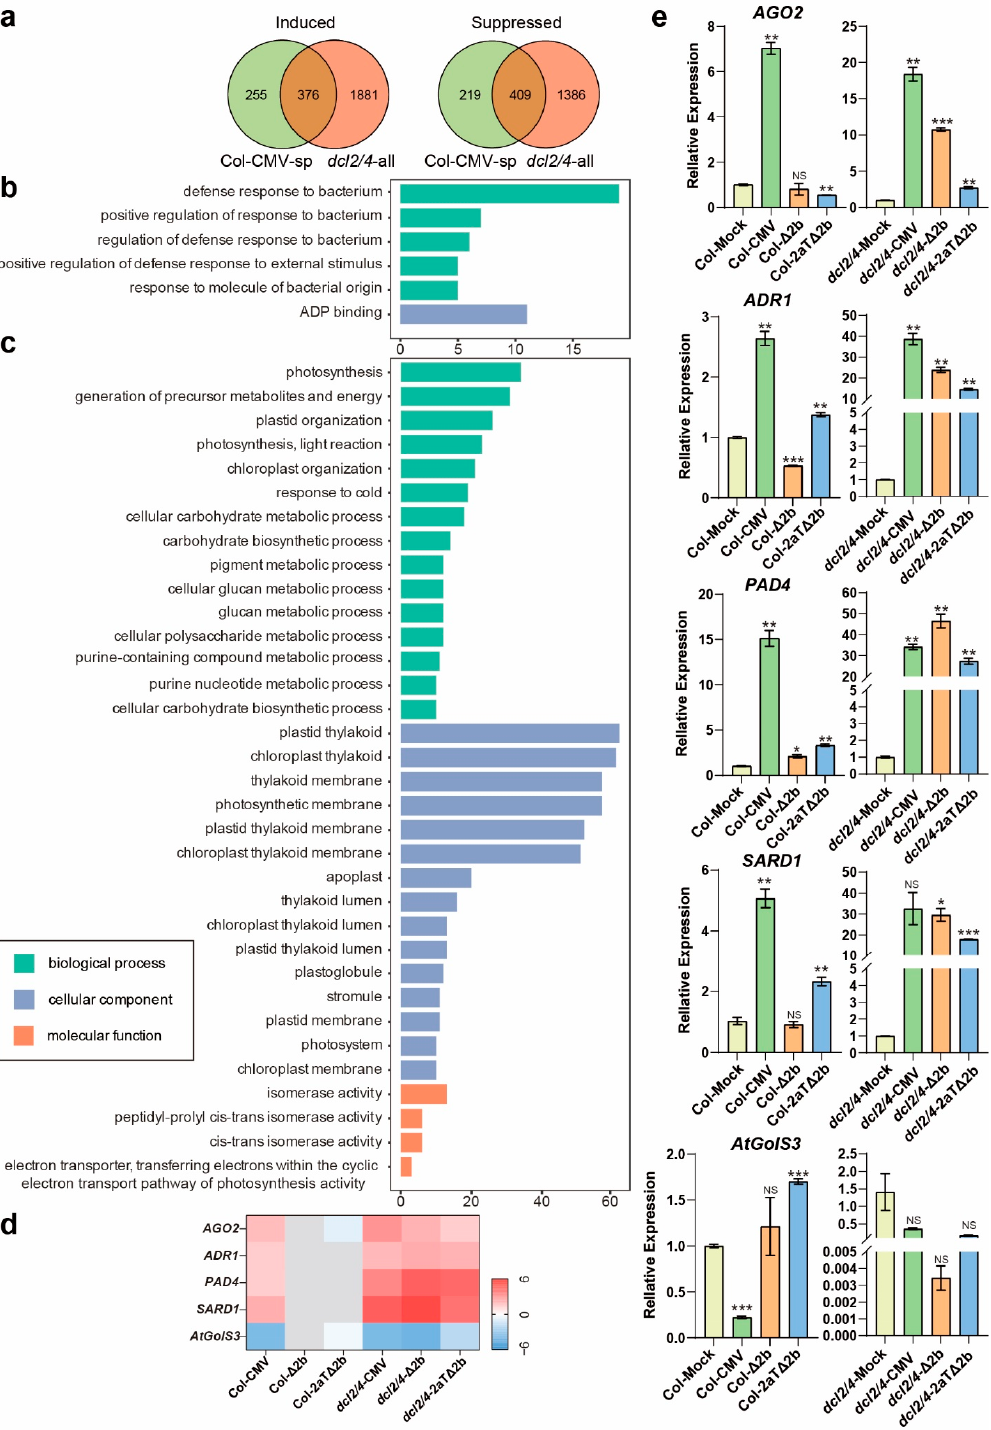
Figure 3. DEGs overlapped in Col-CMV, dcl2/4 -CMV, dcl2/4 - ∆ 2b, and dcl2/4 -2aT ∆ 2b. ( a ) Comparison of the number of DEGs among different gene sets in symptomatic infected plants. ( b ) GO terms enriched for induced DEGs. ( c ) Top 15 GO terms enriched for suppressed DEGs. The y-axis represents the enriched GO term, and the x-axis represents the number of DEGs in the term. Different colors are used to distinguish biological processes, cellular components and molecular functions. ( d ) Heat map of part DEGs changed dramatically in sick plants. ( e ) Relative transcriptional level of AGO2 , ADR1 , PAD4 , SARD1 and AtGolS3 . Values are means ± SEM. *, P < 0.05; **, P < 0.01; ***, P < 0.001; NS, no significance ( n = 3, two-tailed Student’s t